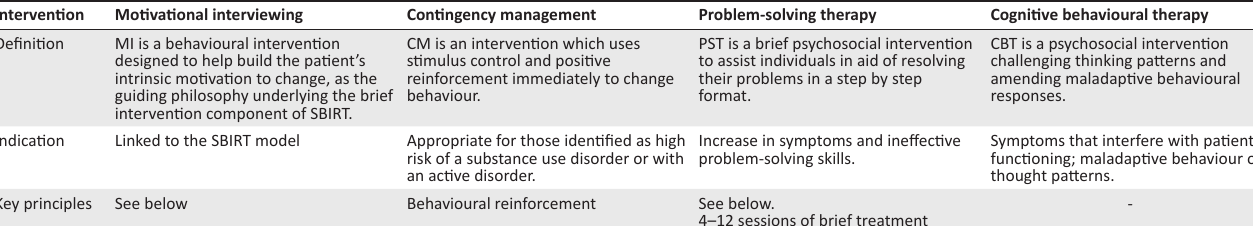
TABLE 2-A4: Summary of brief intervention